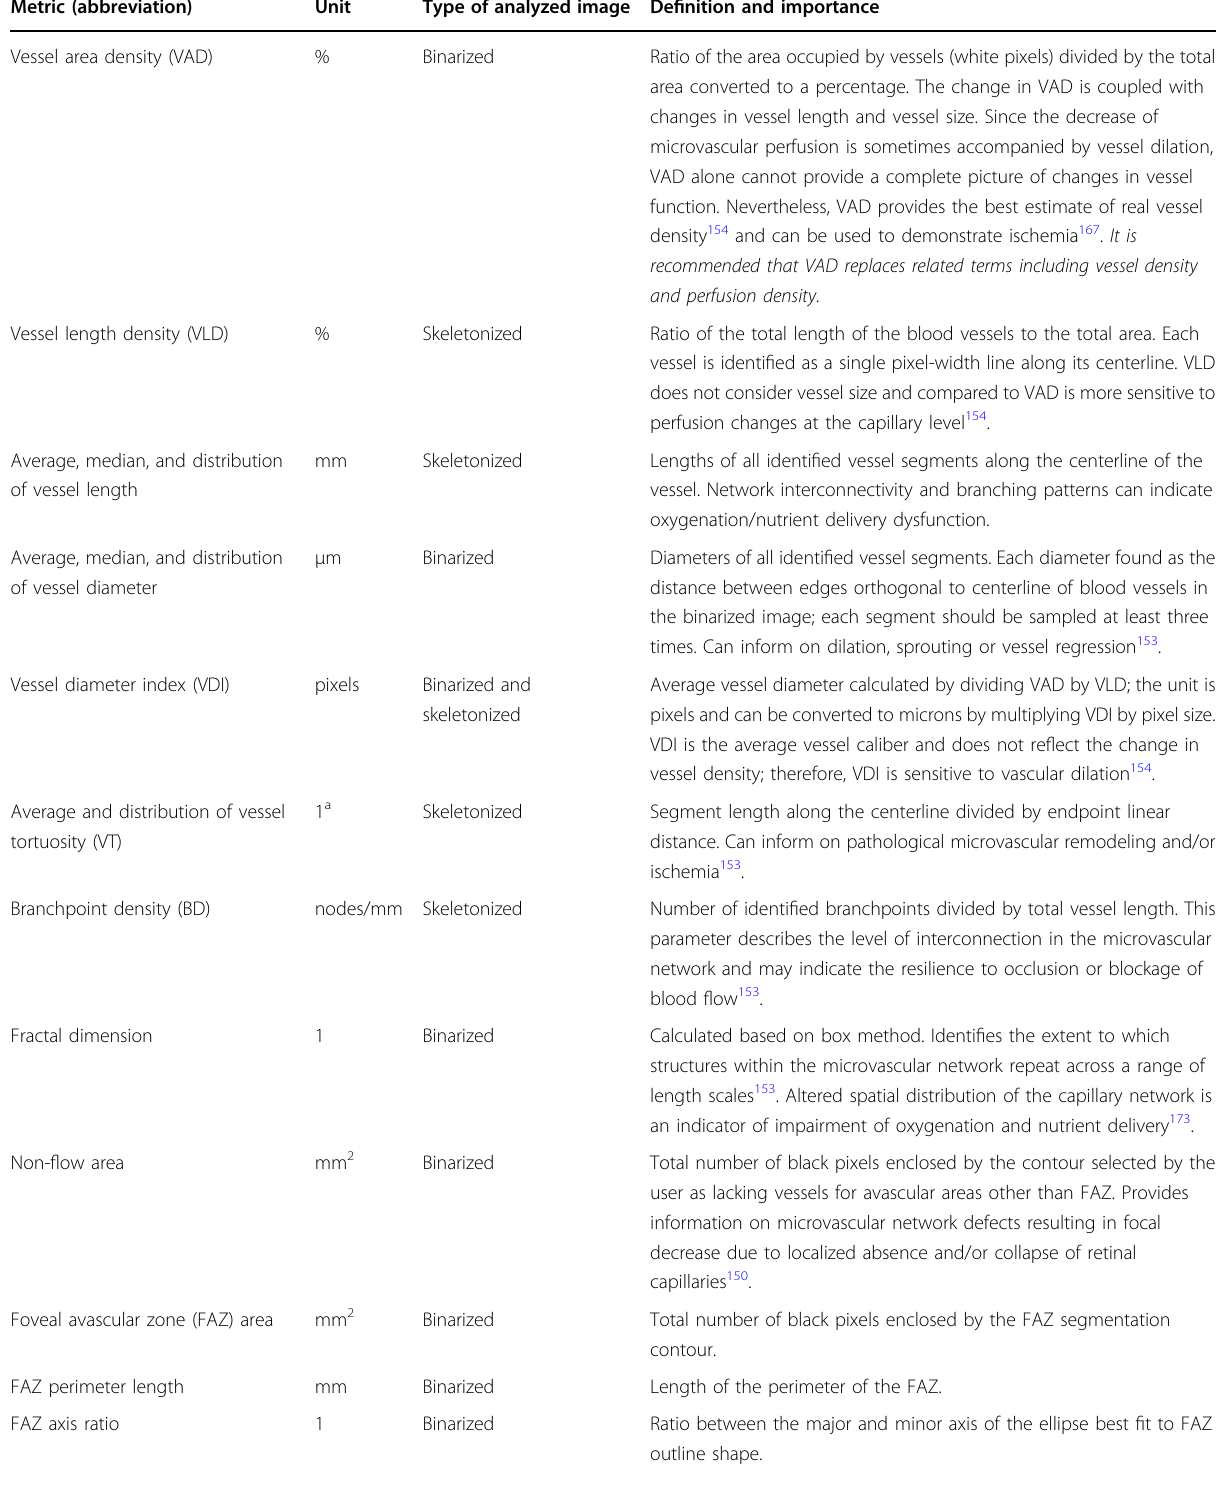
Table 1 Recommended metrics for characterization of the retinal microvascular network architecture and characterization of foveal avascular zone based on en face OCTA